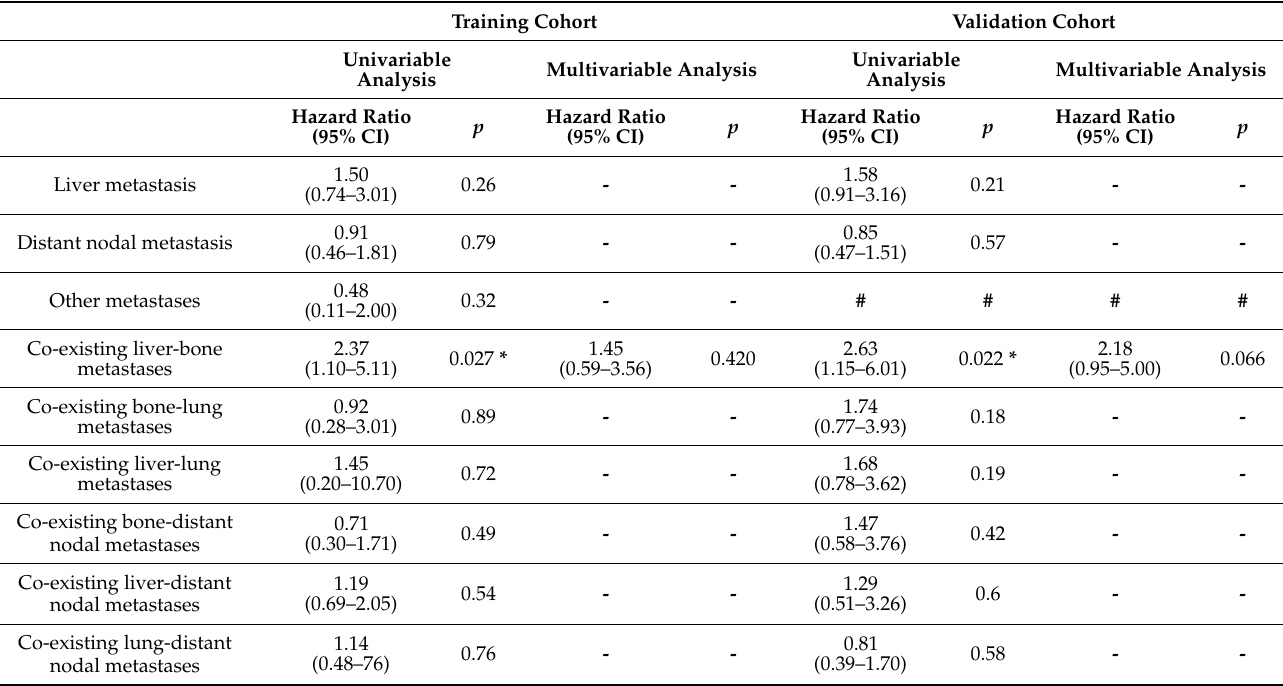
analysis. Significant covariates are in bold. # No metastases in other parts of the body in the valida- tion cohort.